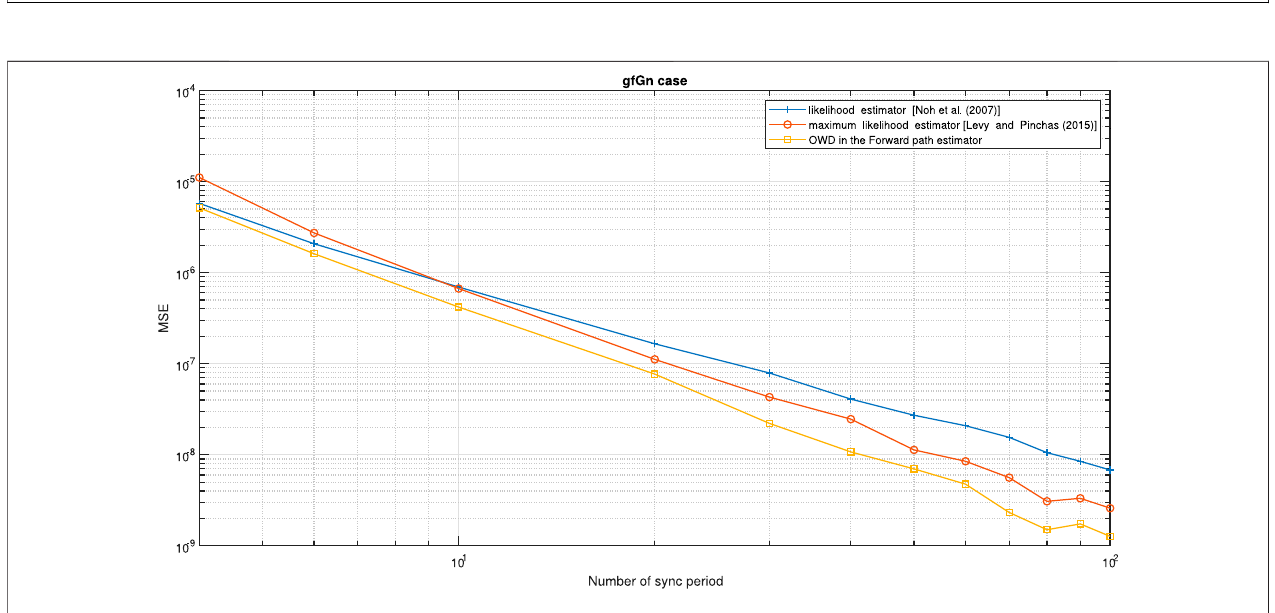
) , H =0.95, a =0.08, d σ 2 (cid:2) 9 e − 8 [ sec 2 ] , ω 1 ms =5 ms , d sm =5.5 ms , sec